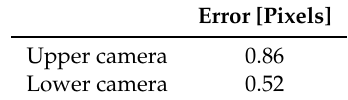
Table 2. Calibration error on the catadioptric camera.